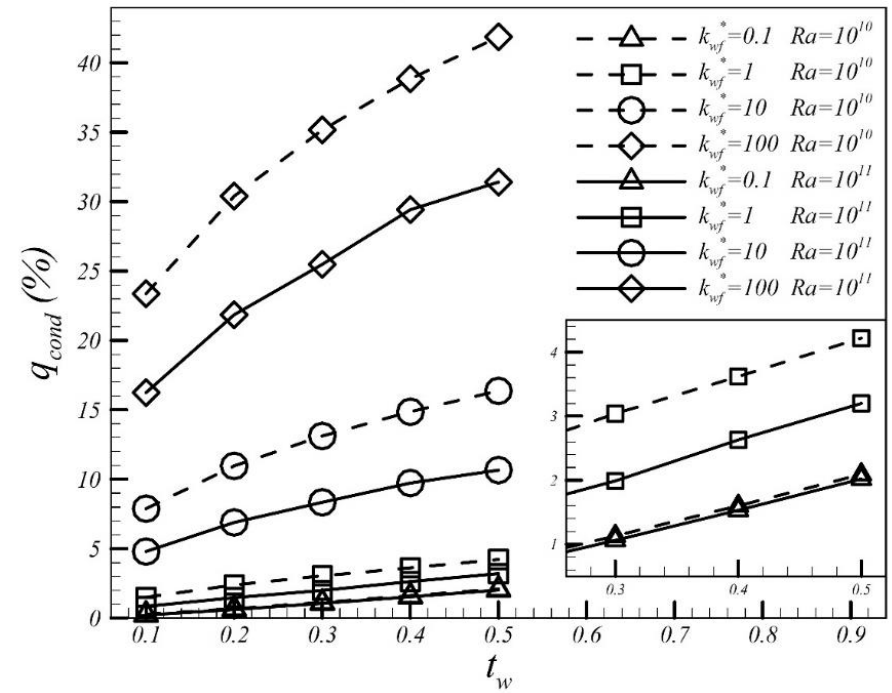
Figure 7. Variation in the thermal conductivity ratio of the pipe wall of the cooling section q cond with t w ( AR = 1, l ∗ = 0.8, l z = 2, Sb ∗ = 0.6, Ste ∗ = 0.1, and c v = 10%). For the loop with water as its working fluid, ε h = 1 (marked by the red dotted